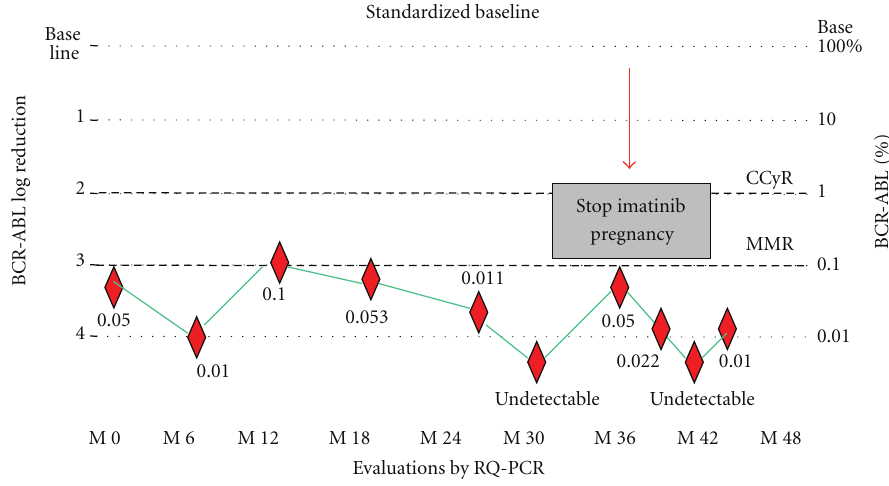
Figure 1: Evolution of molecular response during imatinib